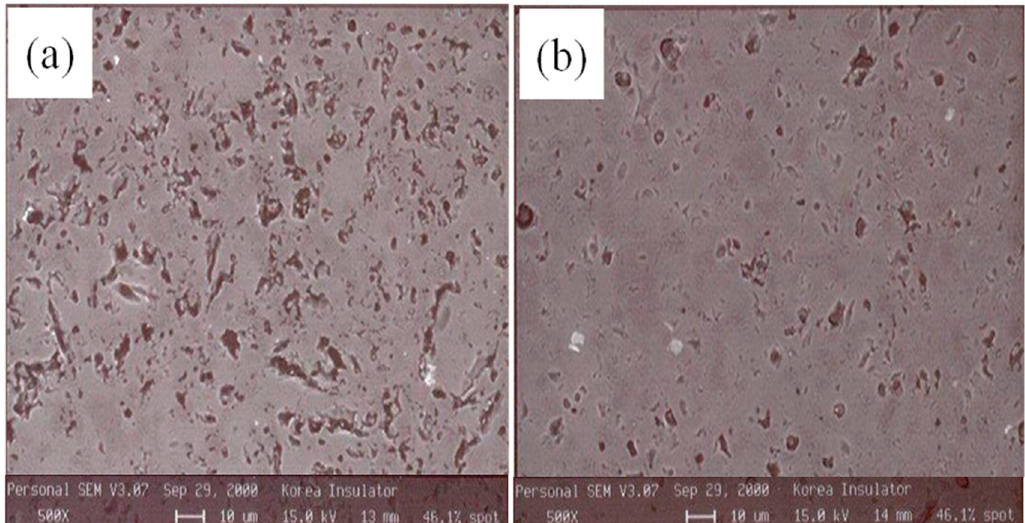
Figure 8. SEM images of porcelain of porcelain insulators; ( a ) 50 years, ( b ) 10 years.